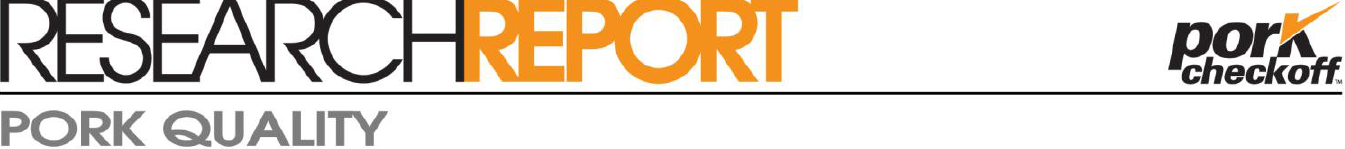
Determining Pork Fat Quality as Measured by Three Methods with an Industry